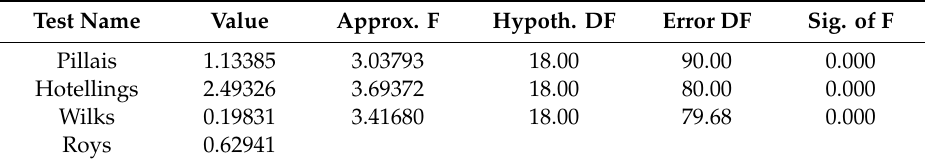
Table 4. Multivariate tests of significance.